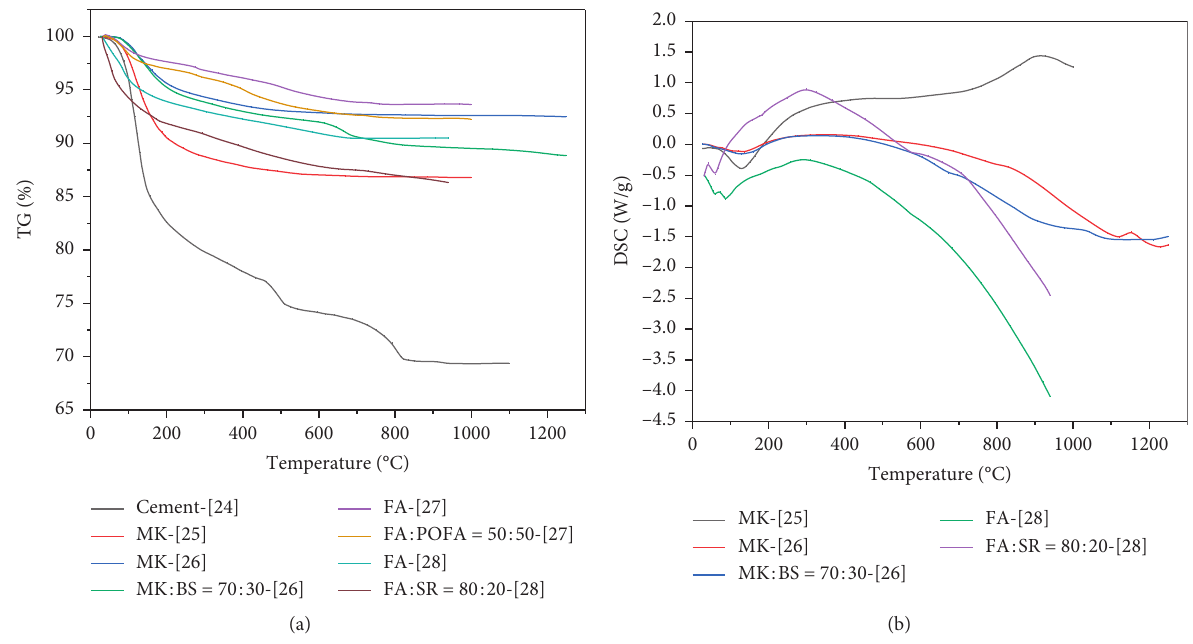
Figure 1: The TG/DSC curves of geopolymers. (a) TG curves. (b) DSC